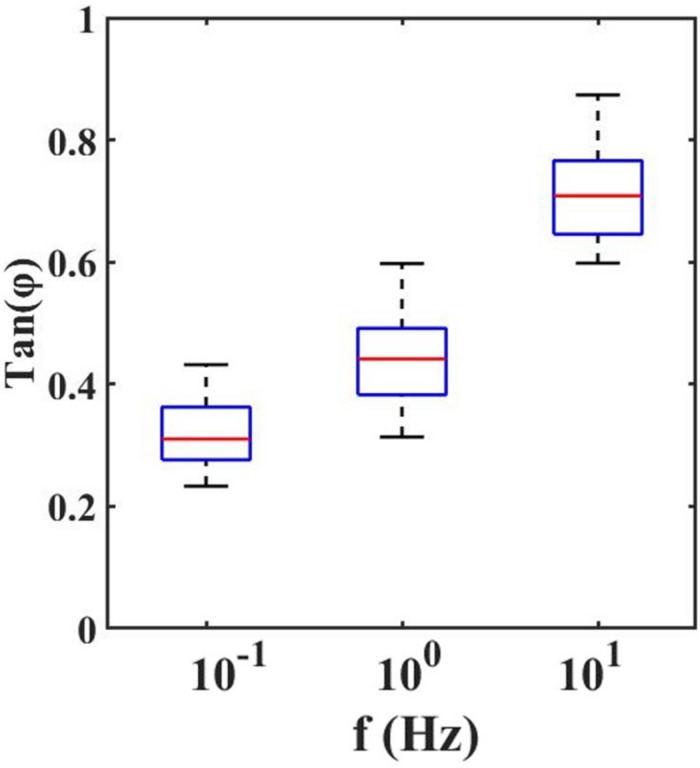
Loss Tangent: the tangent of the phase angle between load and indentation as a function of frequencies.